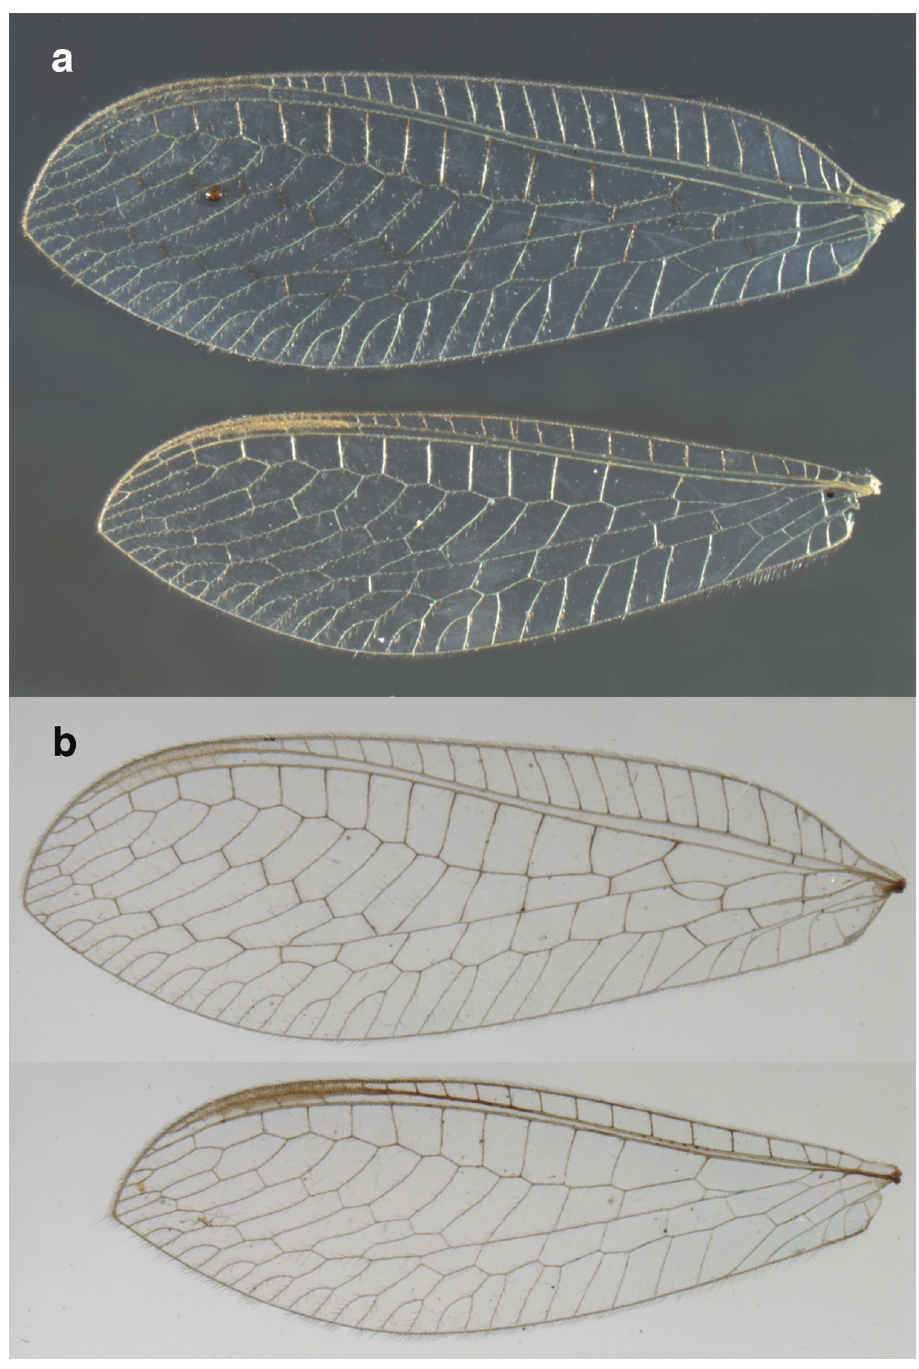
Figure 54. Ungla laufferi (Navás): Wings ( a Peru, Lima, male, FSCA b Peru, Cajamarca, male,